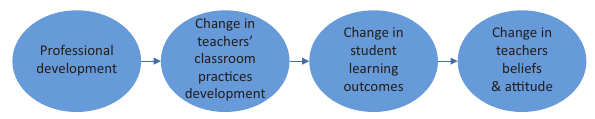
FIGURE 1: A model of teacher